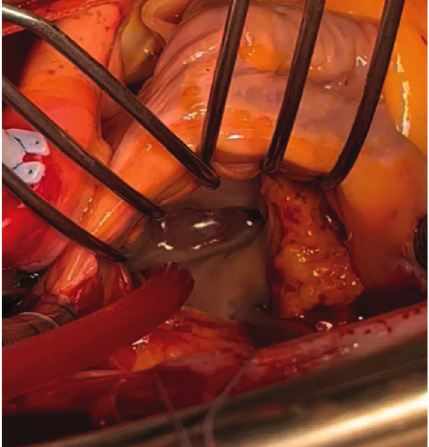
Figure 3: Aneurysm on the atrial aspect of the anterior MV lea fl et (A2